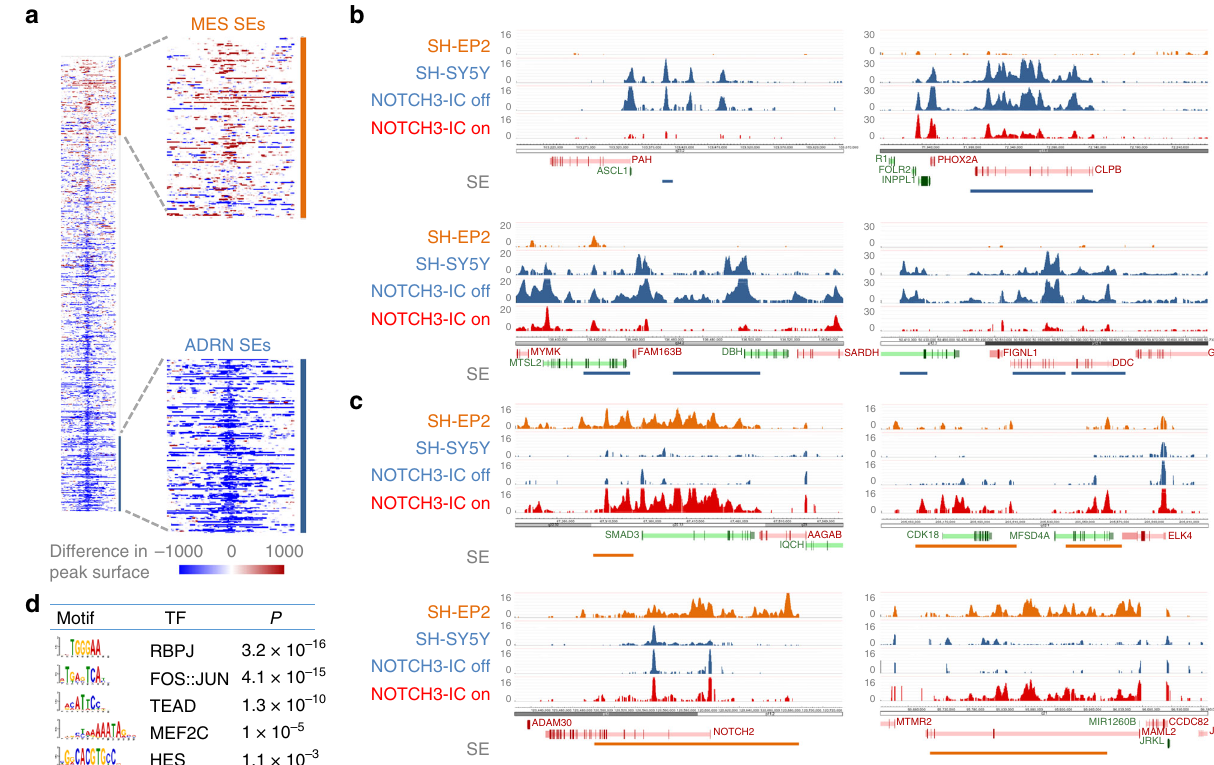
Fig. 4 NOTCH3-IC induces epigenetic remodeling of super-enhancer landscapes. a Analysis of H3K27ac marked super-enhancer regions ( n = 1662) that were previously shown to be associated with MES or ADRN cells in neuroblastoma 1 . Shown are changes of H3K27ac signal in SH-SY5Y cells with induced expression of NOTCH3-IC ( T = 7 days of induction). Red (increased) or blue (decreased) H3K27ac signal of the super-enhancers is depicted by horizontal bars on the genomic regions. Expanded views show the super-enhancer (SE) regions that distinguish MES and ADRN lines (indicated by orange and blue vertical bars, respectively) (right). b , c H3K27ac pro fi les in SH-EP2, SH-SY5Y and in SH-SY5Y cells with (NOTCH3-IC on) or without (NOTCH3-IC off) 7 days of doxycycline-induced expression of NOTCH3-IC. Shown are examples of b ADRN-speci fi c SE-associated TF genes ( ASCL1 , PHOX2A ) and ADRN lineage genes ( DBH , DDC ). In c , examples of MES-speci fi c SE-associated TF genes ( SMAD3 , ELK4 , NOTCH2 , MAML2 ) are shown. SEs associated with ADRN- and MES cells are indicated by blue and orange horizontal bars, respectively. Gene color depicts orientation on sense (green) and anti-sense (red) DNA strands. d . Motif analysis on regions with increased H3K27ac signal. Statistical signi fi cance of enrichment was calculated using Fisher ’ s exact test with Bonferroni